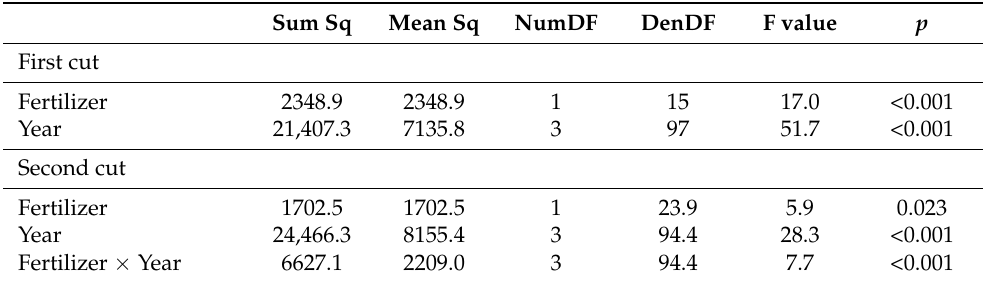
Table 4. Effects of fertilizer and year on the crude fiber of the first cut in early June and the second cut in mid-August according to the minimal adequate model. Both models had two levels for the fertilizer and four levels for year (Figure